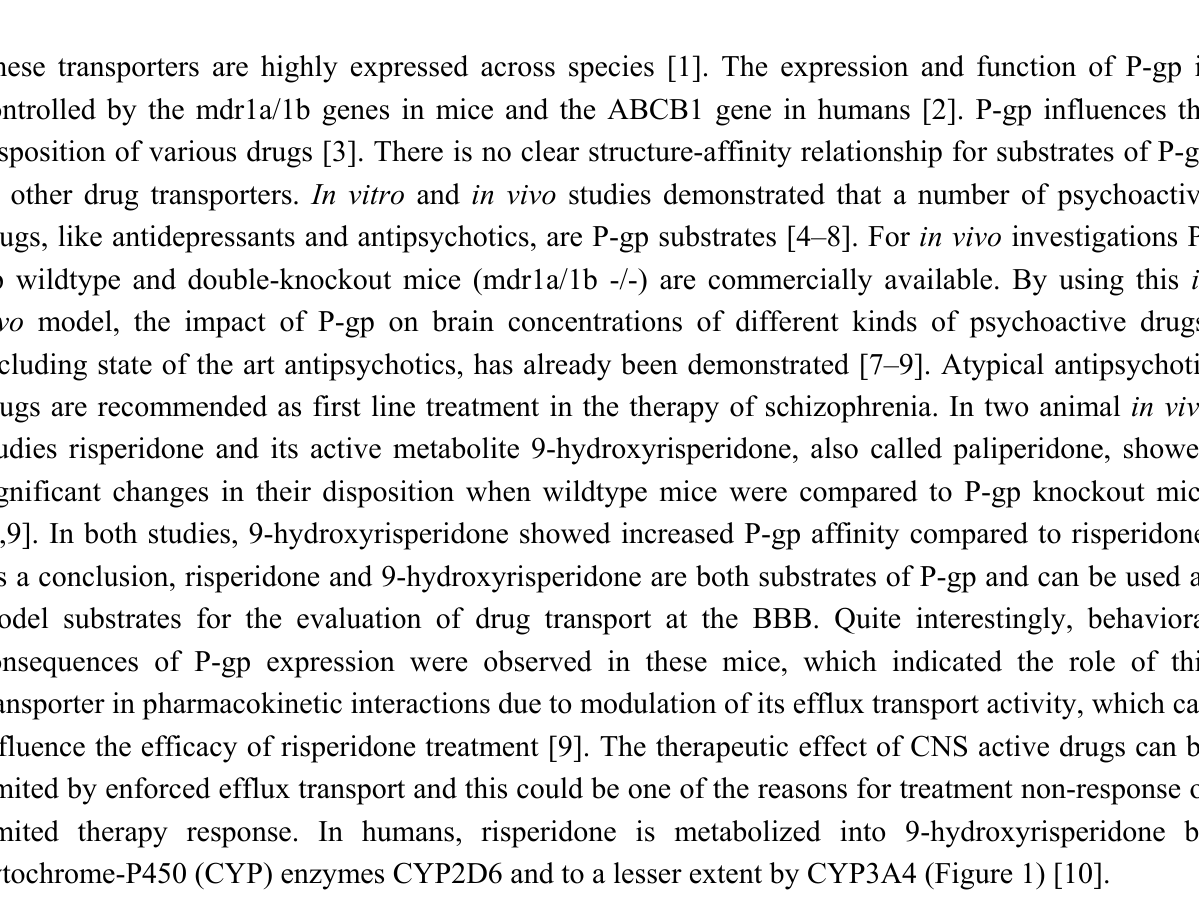
Figure 1. Metabolism of risperidone in humans